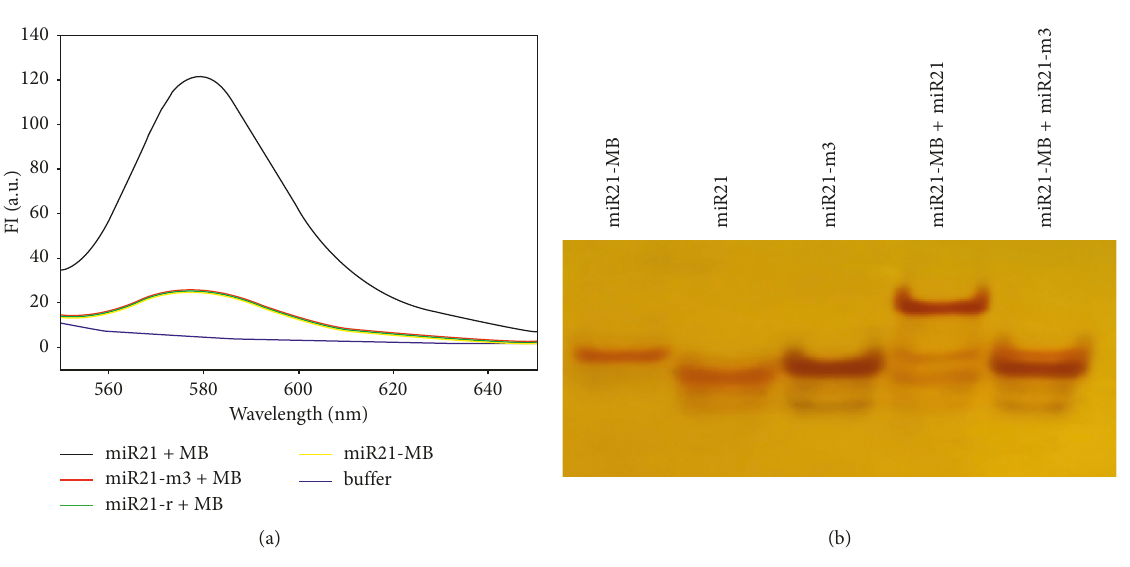
Figure 3: The specificity assay of MB with target by fluorescence spectrometry (a) and polyacrylamide gel electrophoresis staining by silver